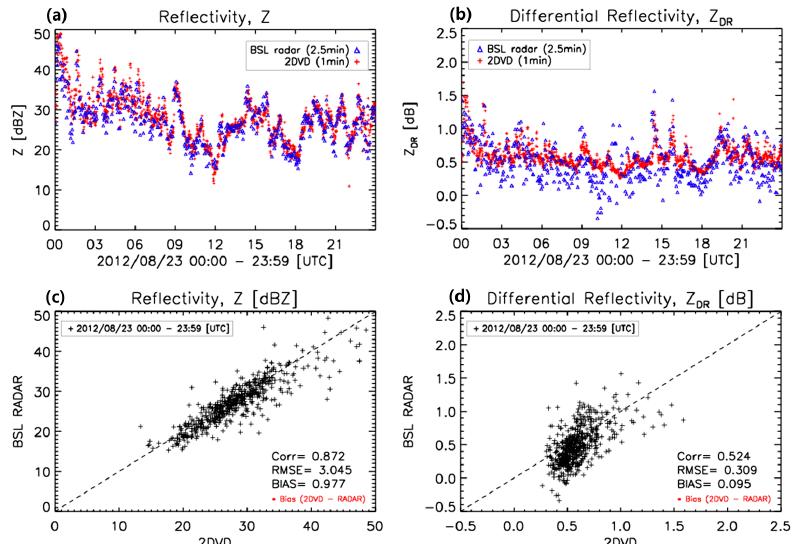
Figure 9. Time series of the (a) reflectivity and (b) differential reflectivity obtained by 2DVD and BSL S-band radar, and scatter plots of the 2DVD estimations and radar measurements for the (c) reflectivity and (d) differential reflectivity. Comparison statistics including the correlation coefficient (Corr), RMSE, and bias are also presented (measurements were collected on 23 August 2012).